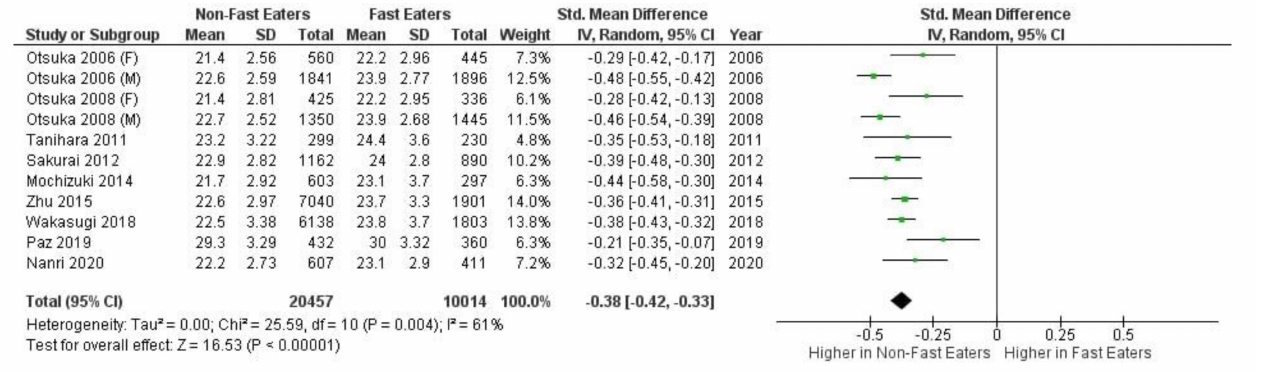
Figure 2. Forest plot of meta-analysis slow and fast eating speed according to the included observational studies.